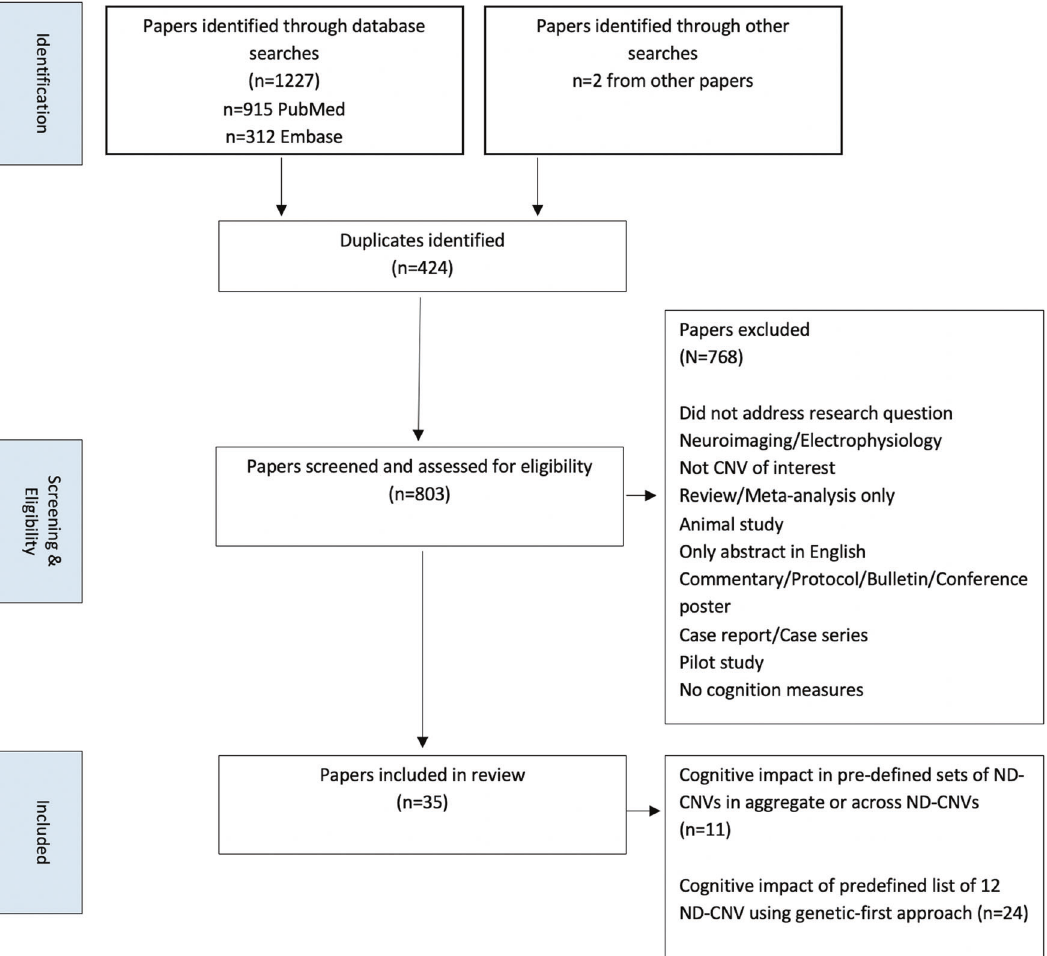
Fig. 1 Flowchart of literature search and fi ltering of papers to be included in the fi nal review. Papers were identi fi ed through database searches and then screened for eligibility for inclusion based on speci fi c